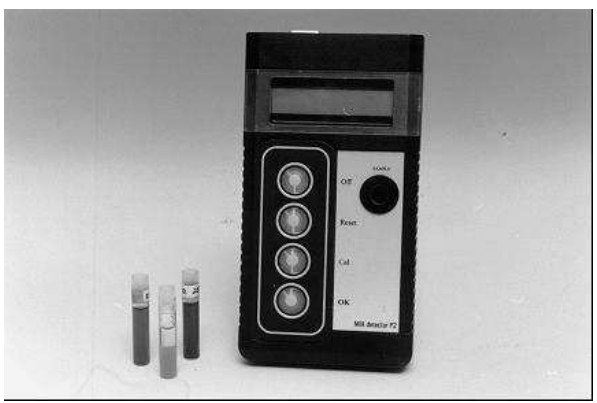
Figure 6. The current magnetic permeability meter, a portable version of the device ( Reprinted from [21] with permission from Elsevier ).